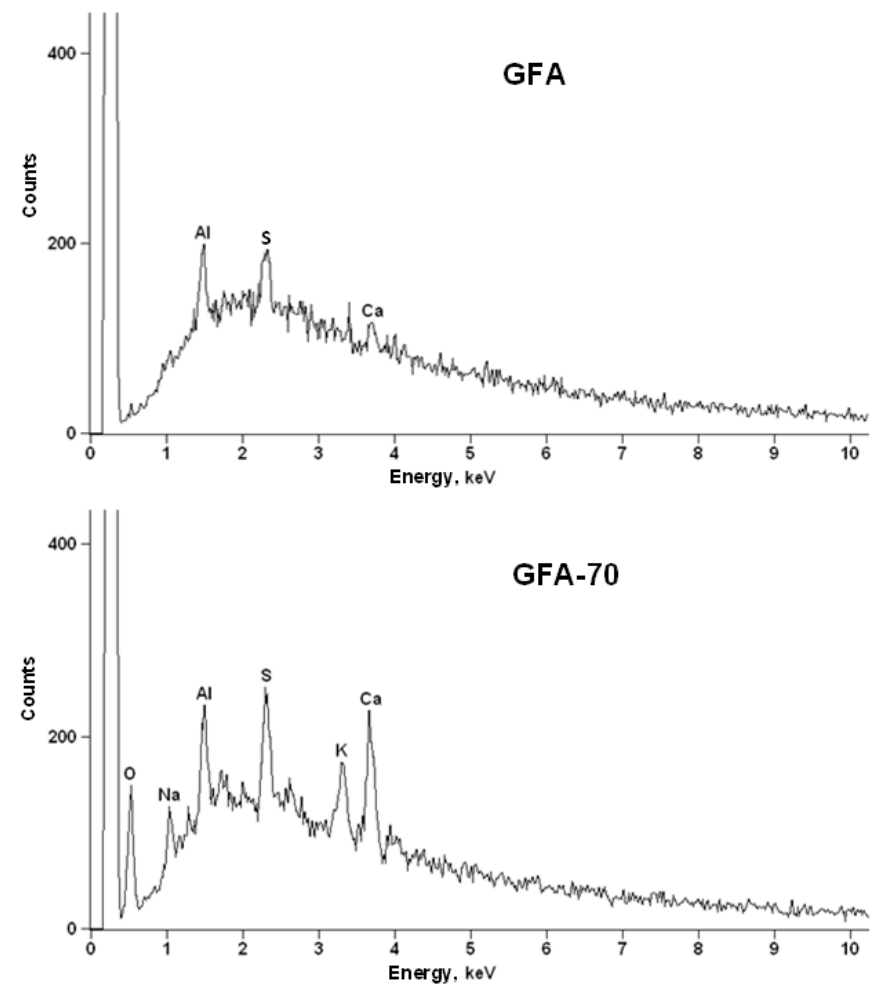
Figure 1. SEM images recorded for GFA ( a ), GFA-35 ( b ), and GFA-70 ( c ) materials.